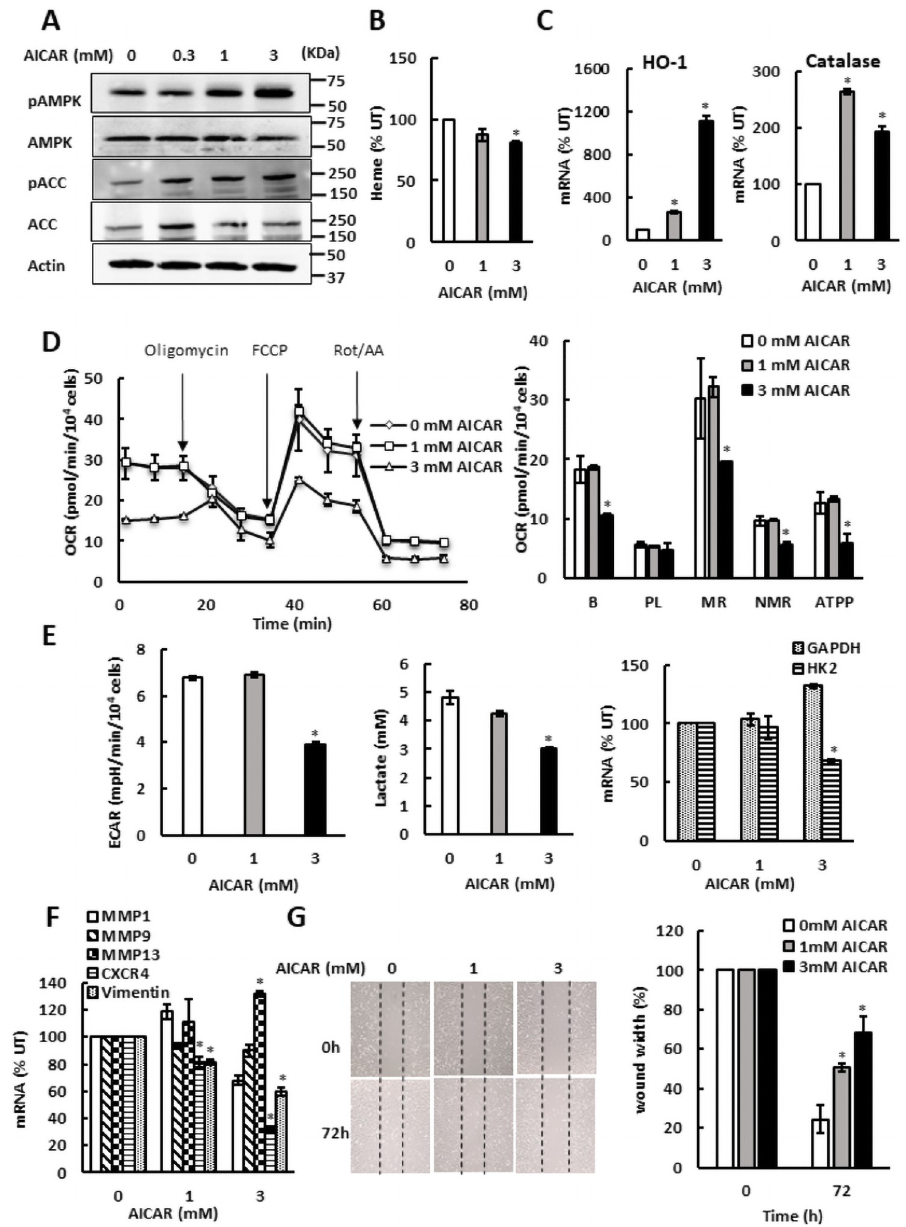
Fig 4. AMPK inhibits mitochondrial respiration and aerobic glycolysis in SKOV3 cells. (A) SKOV3 cells were treated with 0, 0.3, 1, and 3 mM AICAR for 24 h and whole cell extracts were analyzed by Western blotting using antibodies against pAMPK, AMPK, pACC, ACC, and actin. The figure represents typical results from three independent experiments. (B) Cellular heme levels in SKOV3 cells treated with AICAR. (C) HO-1 and catalase mRNAs were analyzed by qRT-PCR in SKOV3 cells treated with AICAR for 24 h. (D) OCR was measured in SKOV3 cells treated with AICAR for 24 h. (E) ECAR, lactate accumulation in the medium, and GAPDH and HK2 mRNA levels in SKOV3 cells treated with AICAR for 24 h. (F) Expression of metastatic genes in SKOV3 cells treated with AICAR for 24 h. (G) Migration of SKOV3 cells treated with AICAR for 72 h analyzed by wound healing assay (n = 3). (A-G) The experiments were repeated three times, and the numerical results are shown as means ± S.D. Values that are statistically different ( p < 0.05) from the control (untreated cells) are indicated by an asterisk.